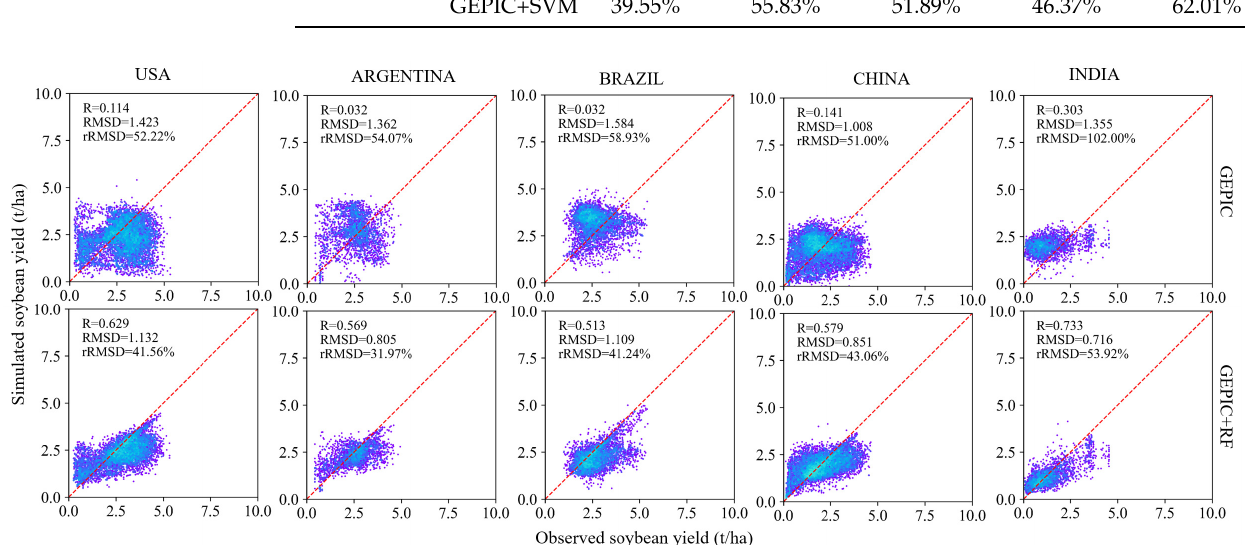
Figure 3. Simulated soybean yield comparisons between GEPIC model and GEPIC+RF during the historic period from 2001 to 2005 for the main producing countries.